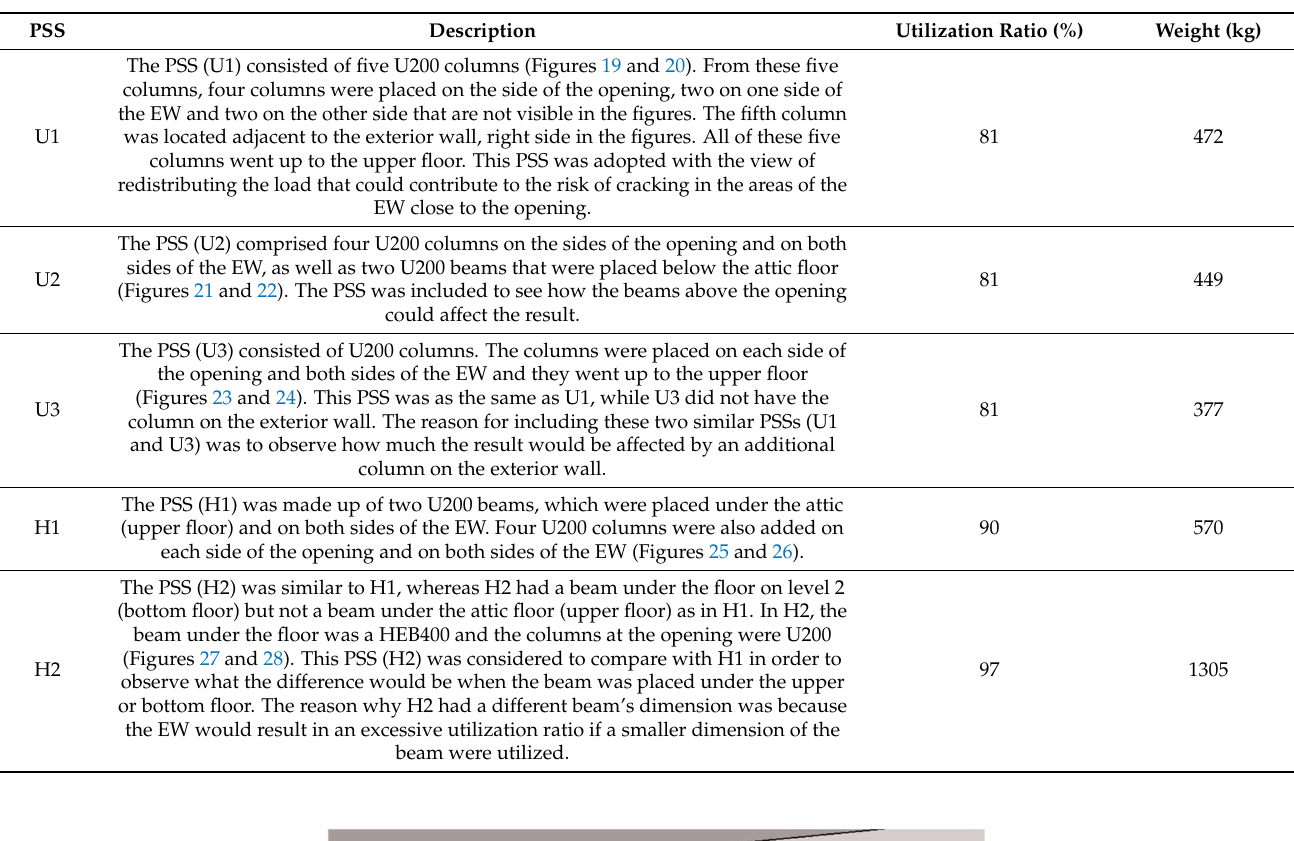
Table 6. Summary of PSSs.